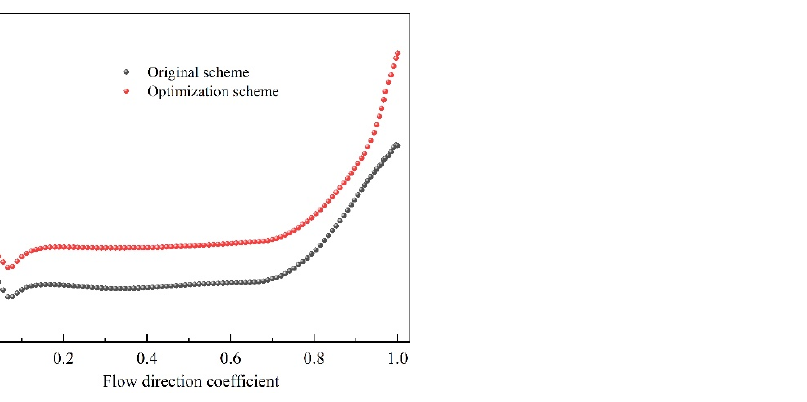
Figure 18. Time-averaged pressure coefficient distribution curve from inlet to outlet of compound impeller before and after optimization under the rated condition.